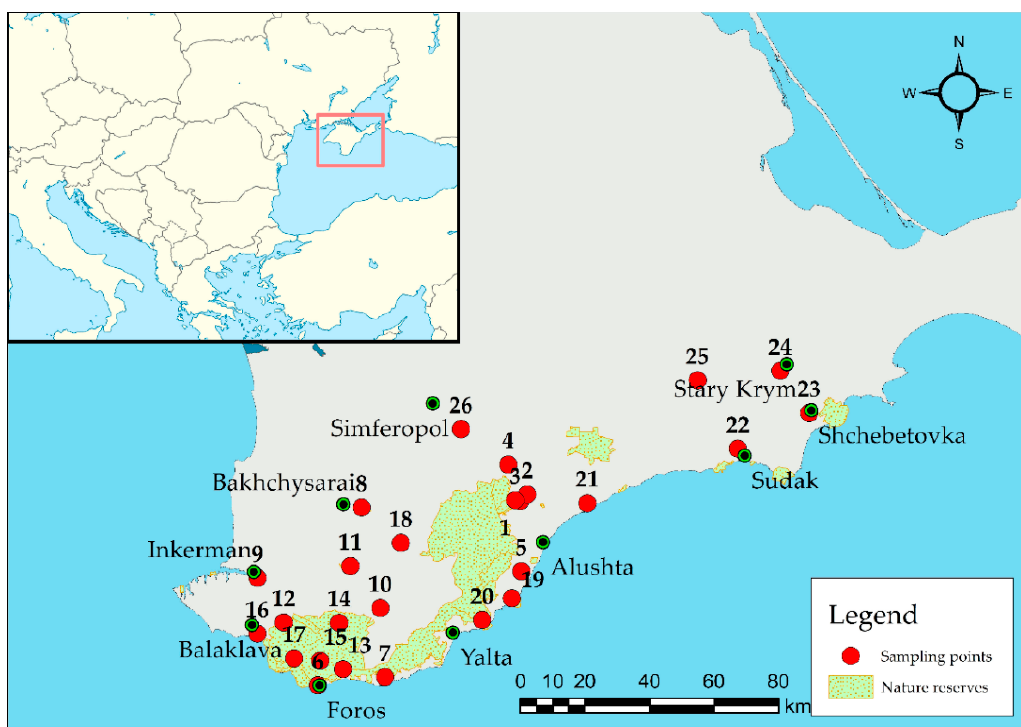
Figure 1. Sampling sites in the mountain Crimea. The main nature reserves are presented in green